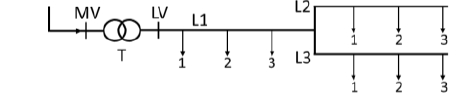
Fig. 6. Example grid structure